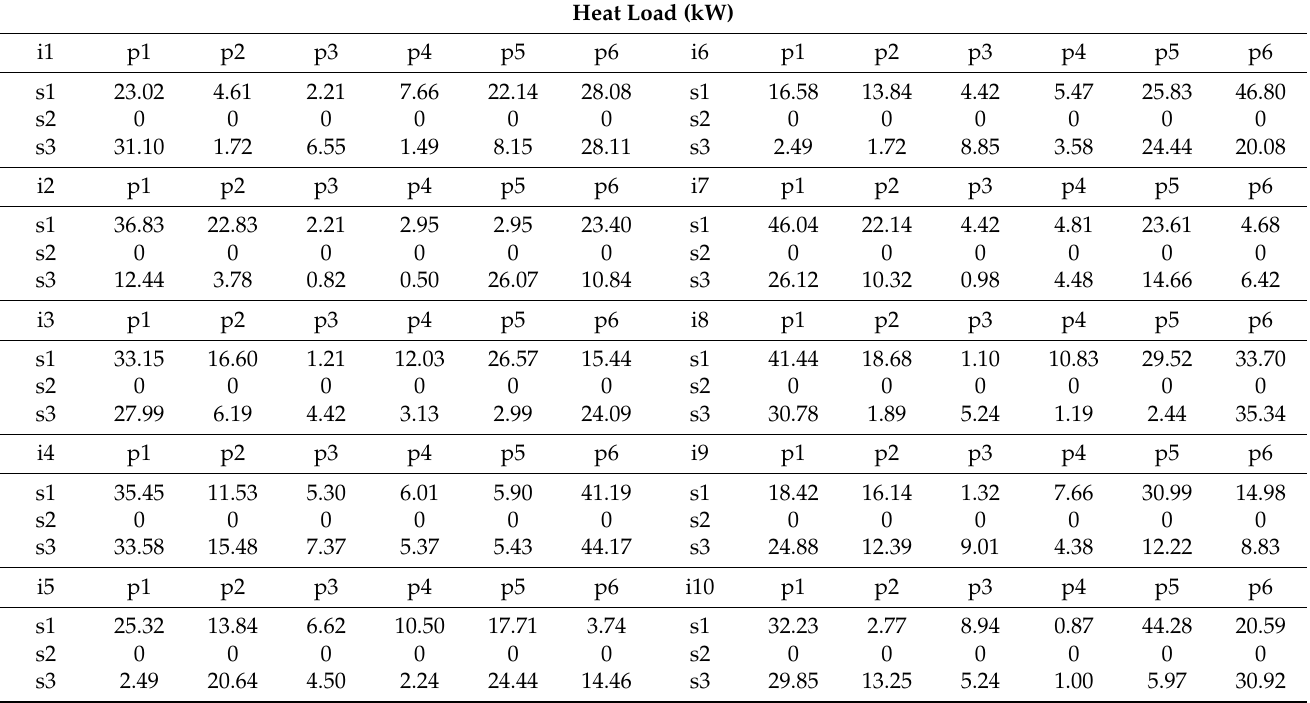
Table 2. Heat loads for the 10 dwellings [24].